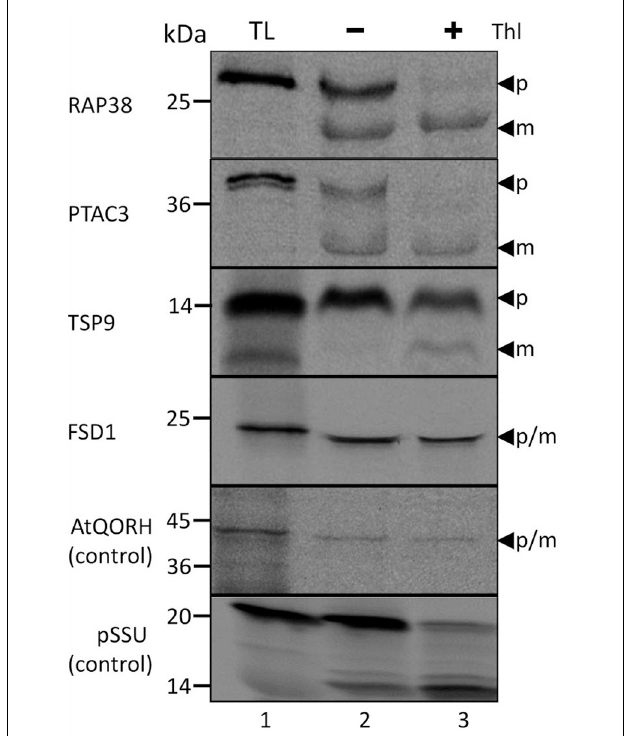
FIGURE 1 | Import of predicted non-canonical chloroplast proteins. In vitro import assays into pea chloroplasts are shown. TL represents 10% of translation product, Thl ( + ) indicates thermolysin digestion after the import reaction. The arrowheads indicate precursor (p) and mature (m) proteins. Please note that the mature band of Tsp9 is only visibly present the lane Thl ( + ), thus it cannot be excluded to have originated from the protease treatment. Representative results from n = 3 independent experiments are depicted.